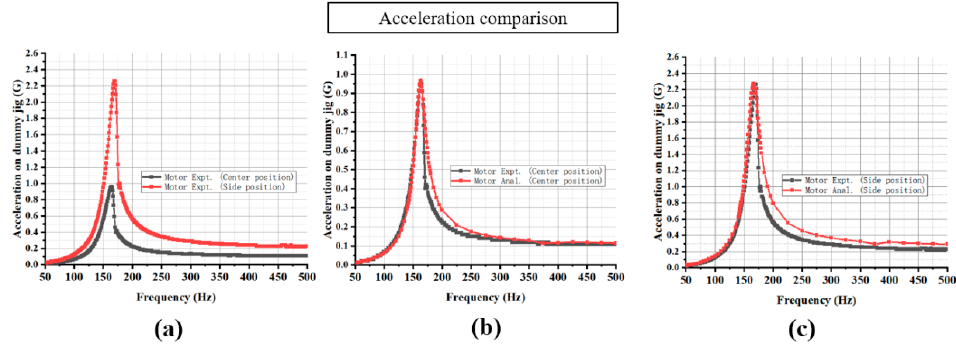
Figure 17. Acceleration comparisons: ( a ) experimental acceleration comparison (center position vs. side position); ( b ) center position (experiment vs. analysis); and ( c ) side position (experiment vs. analysis).